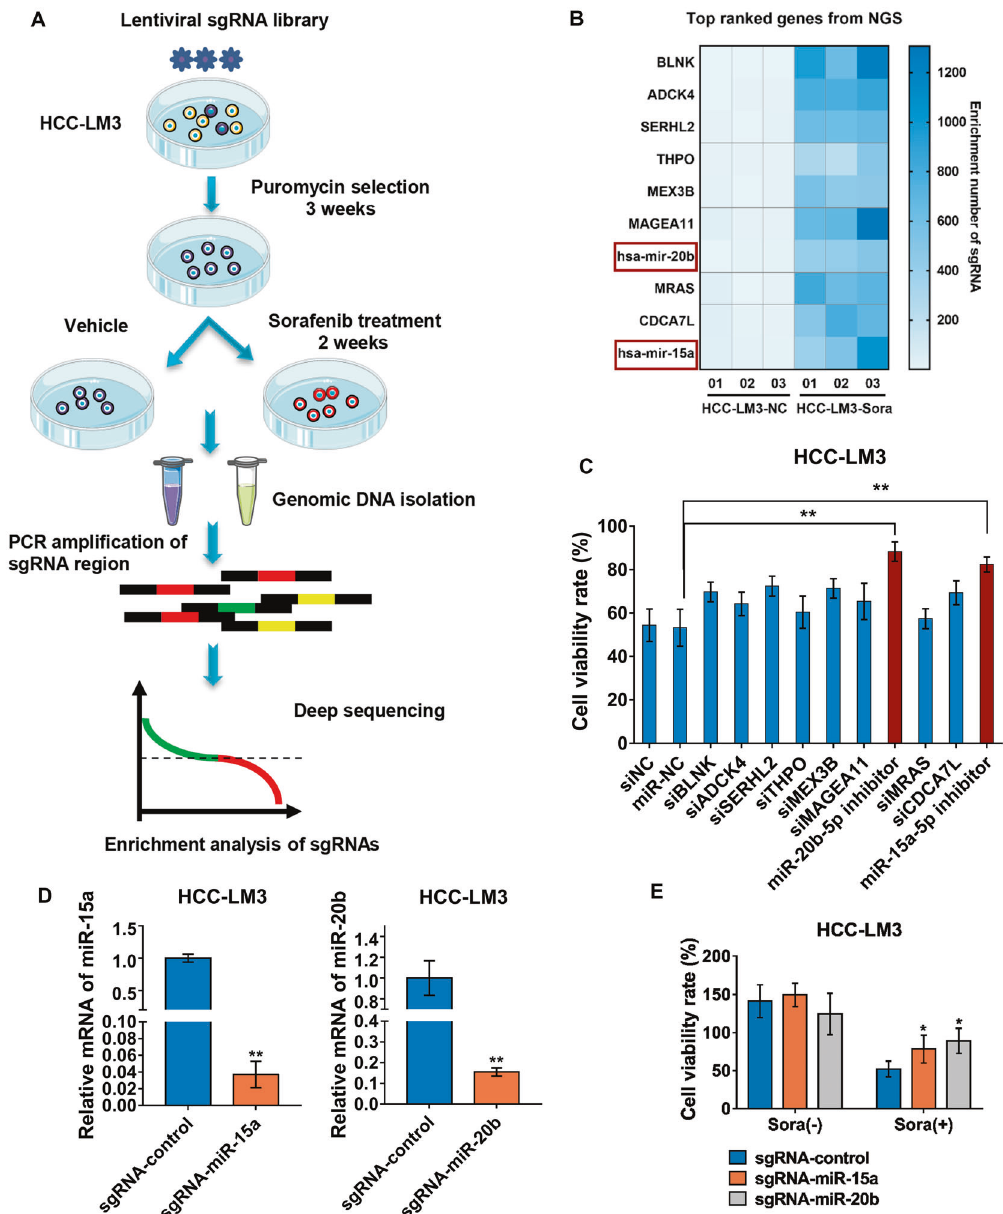
Fig. 1 Genome-Scale CRISPR/Cas9 Screen identi fi ed miR-15a and miR-20b involved in sorafenib response. A Schematic of screening for sorafenib resistance-associated genes in HCC-LM3 cells. B Heat map displayed the rank of sgRNA abundance according to enrichment levels in sorafenib-resistant HCC-LM3 cells. C CCK8 assays were performed in HCC-LM3 cells with silencing of targeting gene as indicated, respectively (one-way ANOVA). D The expression analysis of miR-15a and miR-20b by qRT-PCR (unpaired t test, two-tailed). E The ablation of miR-15a and miR-20b improved cell viability under sorafenib (7.5 μ M) treatment (one-way ANOVA). * p < 0.05, ** p < (Fig. 4F – H). Meanwhile, western blot results con fi rmed that the downregulation of CDC37L1 could enhance the sorafenib- induced cell apoptosis by cleaved PARP (c-PARP) expression, which re fl ects the degree of apoptosis (Fig. 4I). In addition, we resorted to recon fi rm the above fi ndings in vivo via the xenograft model of nude mice. As expected, the results indicated that tumor size and weight derived from CDC37L1-silenced cells were remarkably smaller and lower in response to sorafenib, while no signi fi cant changes were observed between two groups without drug treatment (Fig. 4J, K). Together, these data of in vitro and in vivo experiments implied that CDC37L1 plays a pivotal role in promoting sorafenib resistance in HCC cells.